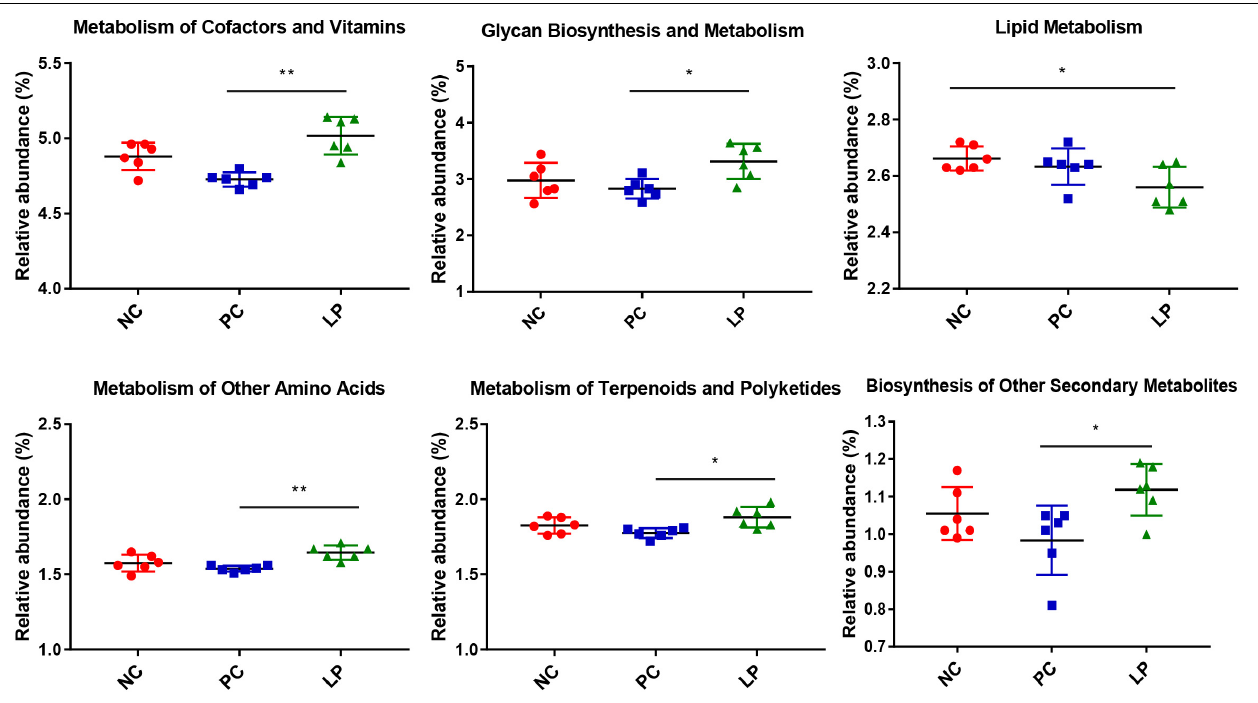
FIGURE 4 | Differences in metabolic functional genes among weaning piglets in NC, PC, and LP groups. ∗ P < 0.05, ∗∗ P < 0.01. TABLE 4 | Concentrations of short-chain fatty acids (SCFAs) in the colonic contents of weaning piglets under the different treatments (mg/g dry weight).